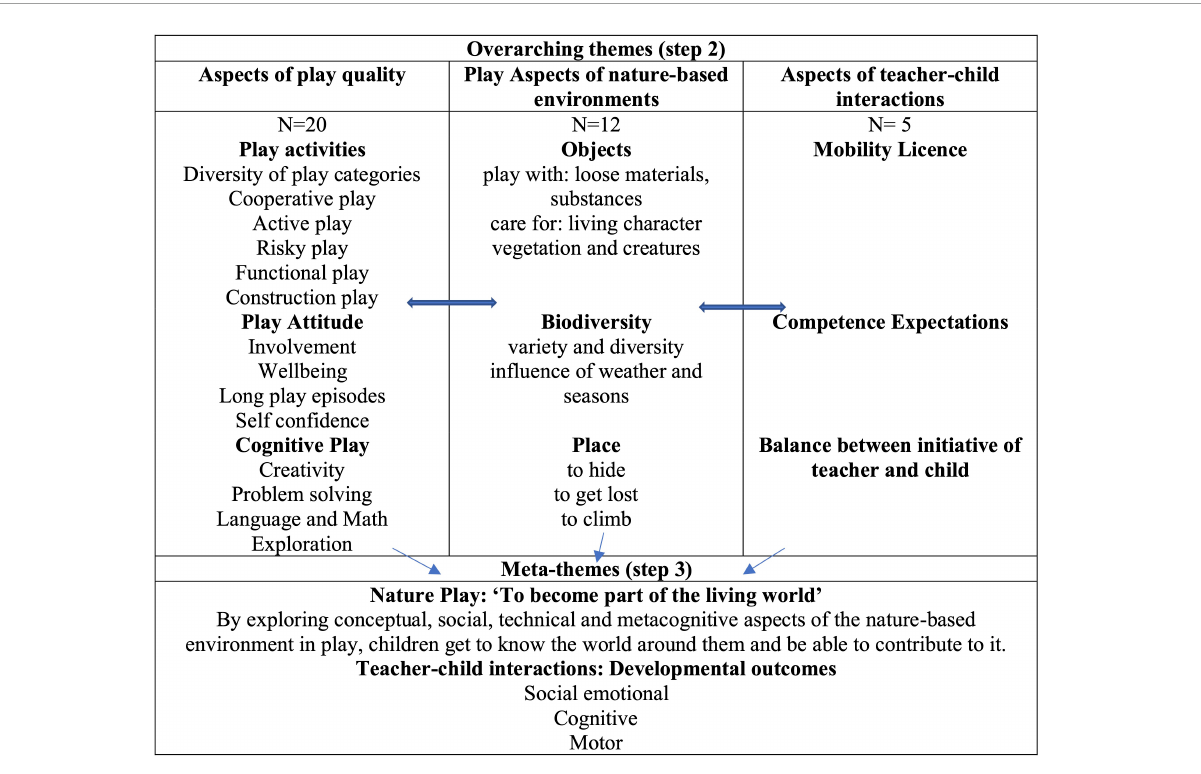
FIGURE2 Meta-synthesis of key concepts into three themes and two